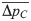
Average change in the frequency of cooperators, ΔpC¯, as a function of the frequency of cooperators, p
C, for a spatially non-additive Snowdrift Game, Eq (9), with selection intensity β = 0.01.The blue and green data are obtained using pairwise comparison updating and differ only in the configuration of the underlying network, which in both cases is a random regular graph of size N = 500 and degree k = 3. Every vertex has a benefit value of b = 4.0, and the cost values are split equally, with half of the vertices having c
1 = 0.5 and the remaining half having c
2 = 5.5. The average payoff for mutual cooperation, Eq (11), is 3.069 (blue) and 2.961 (green), which suggests that the former arrangement is more attractive for cooperation. The analytical predictions (solid lines) are obtained from Eq (48) in Methods (and are linear in β for β ≪ 1).